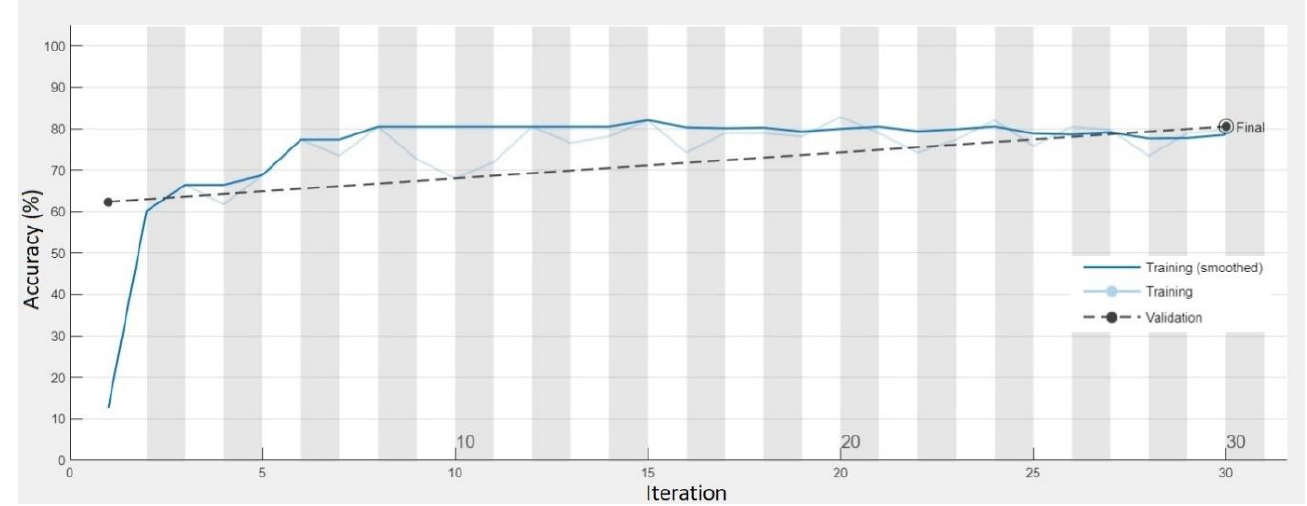
Figure 7. Accuracy of the CNN classifier trained using the ADAM algorithm.